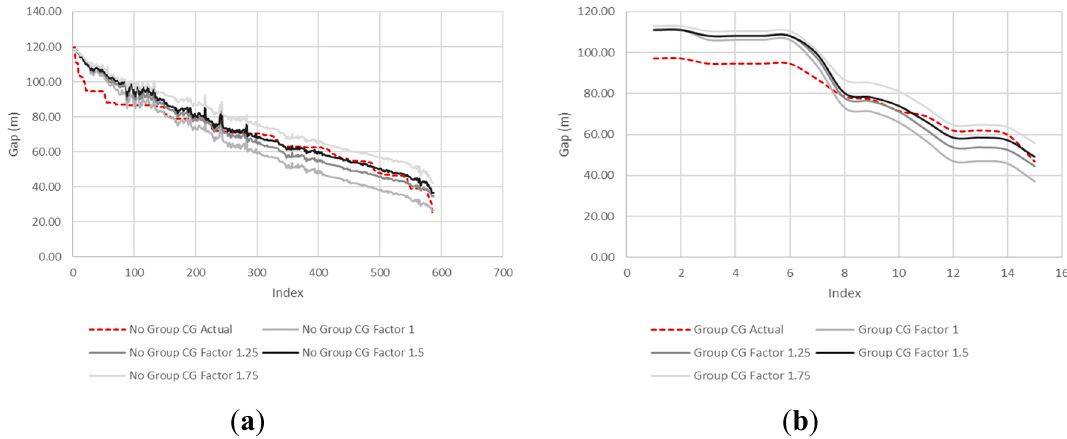
Figure 10. Comparison between actual data and simulation results per pedestrian group movement. ( a ) Crossing individually; ( b ) crossing in a group.